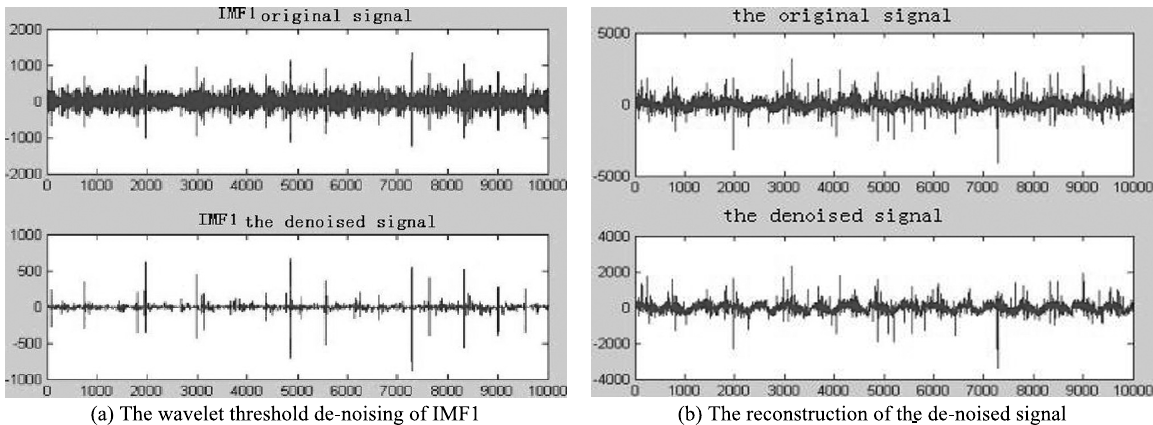
Fig. 3. The wavelet threshold de-noising based on EMD for a crack fault signal at 300